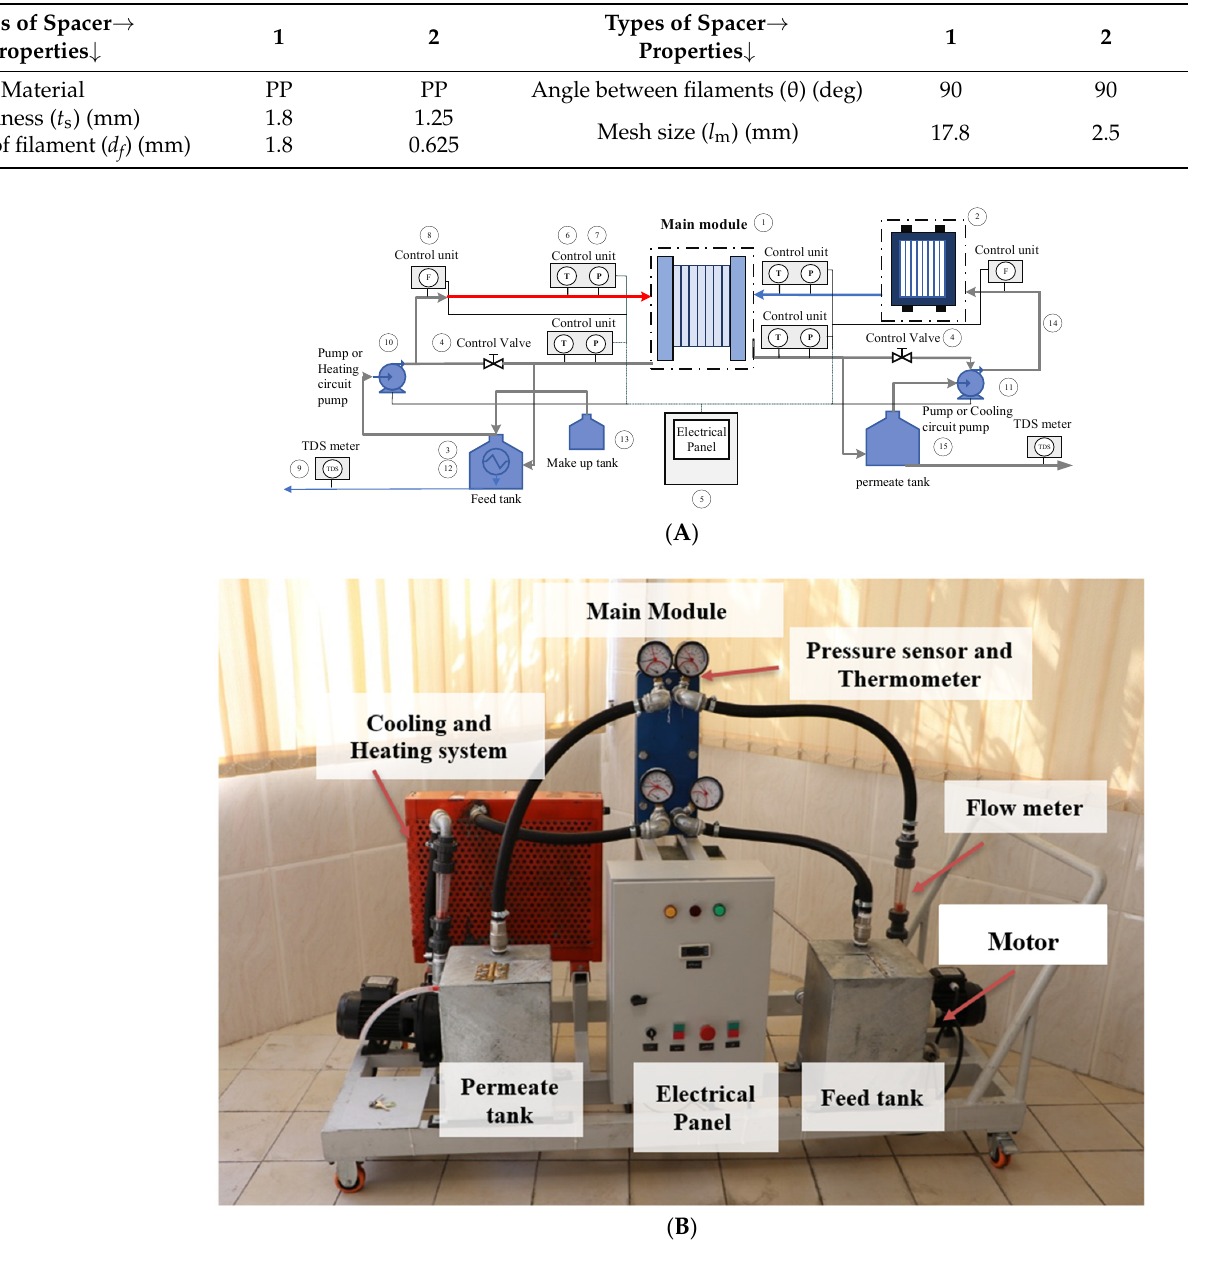
Figure 5 The experimental set up: ( A ) schematic, ( B ) IWET set up. Figure 5. The experimental set up: ( A ) schematic, ( B ) IWET set